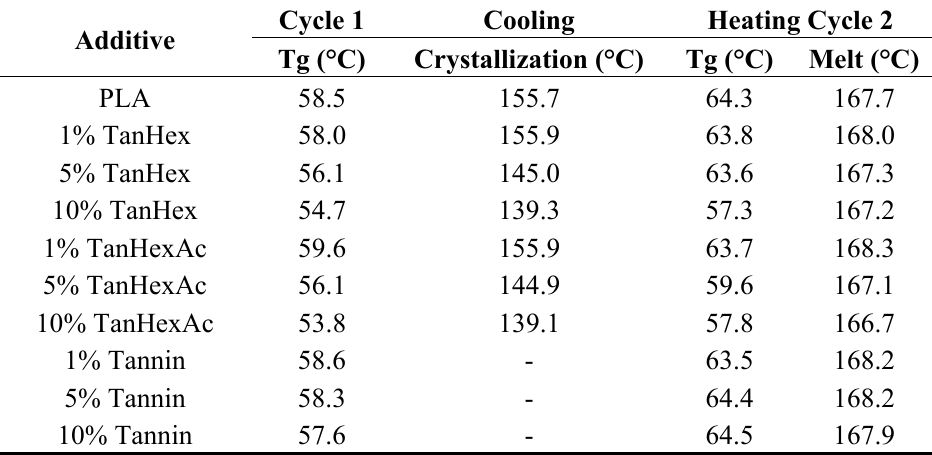
Table 3. Results of DSC analysis of selected PLA samples modified by tannin, TanHex and TanHexAc (see supplementary material).